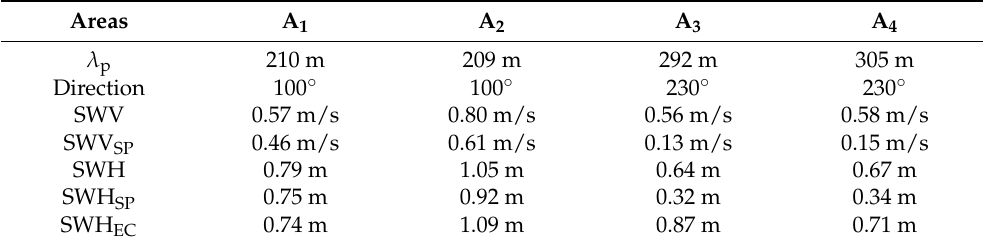
Figure 8. The retrieved sea surface profiles from the spaceborne hybrid InSAR images and airborne hybrid InSAR images: ( a ) A 1 ; ( b ) A 2 ; ( c ) A 3 ; ( d ) A 4 ; ( e ) M920; ( f ) M3120. Table 4. The ocean wave parameters retrieved from the spaceborne hybrid InSAR images and the SWHs provided by